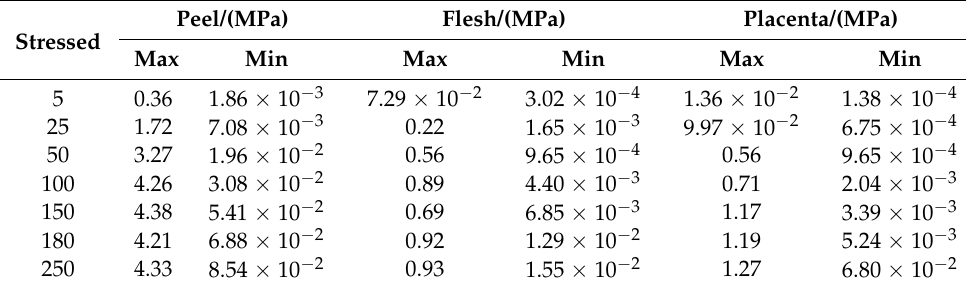
Figure 6. Kiwifruit bruises from different forces. ( a )25 N; ( b )180 N. Note: The red circle is the bruise. Table 2. Stress statistics table for each part of the kiwifruit.